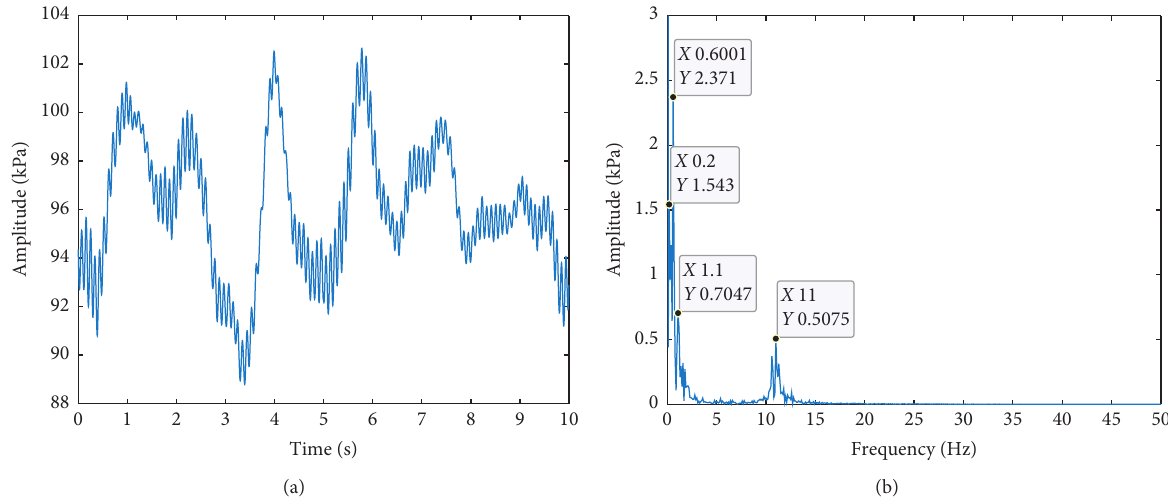
Figure 9: Waveform and spectrum diagram of the draft tube after ALIF-SVD noise reduction. (a) Waveform diagram. (b) Spectrogram.